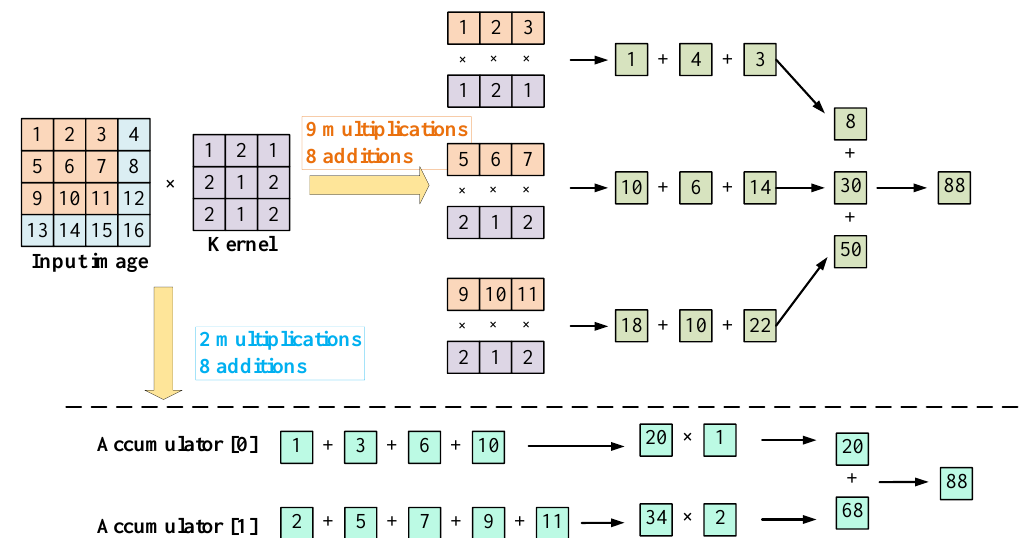
Figure 14. A simple operation used to reduce multiplication.